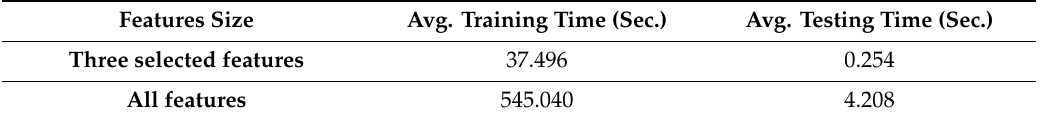
Table 11. Average times taken for the GXGBoost model using 1,334,236 instances of the training set to detect Mirai, Bashlite, and benign classes from 333,560 instances of the testing